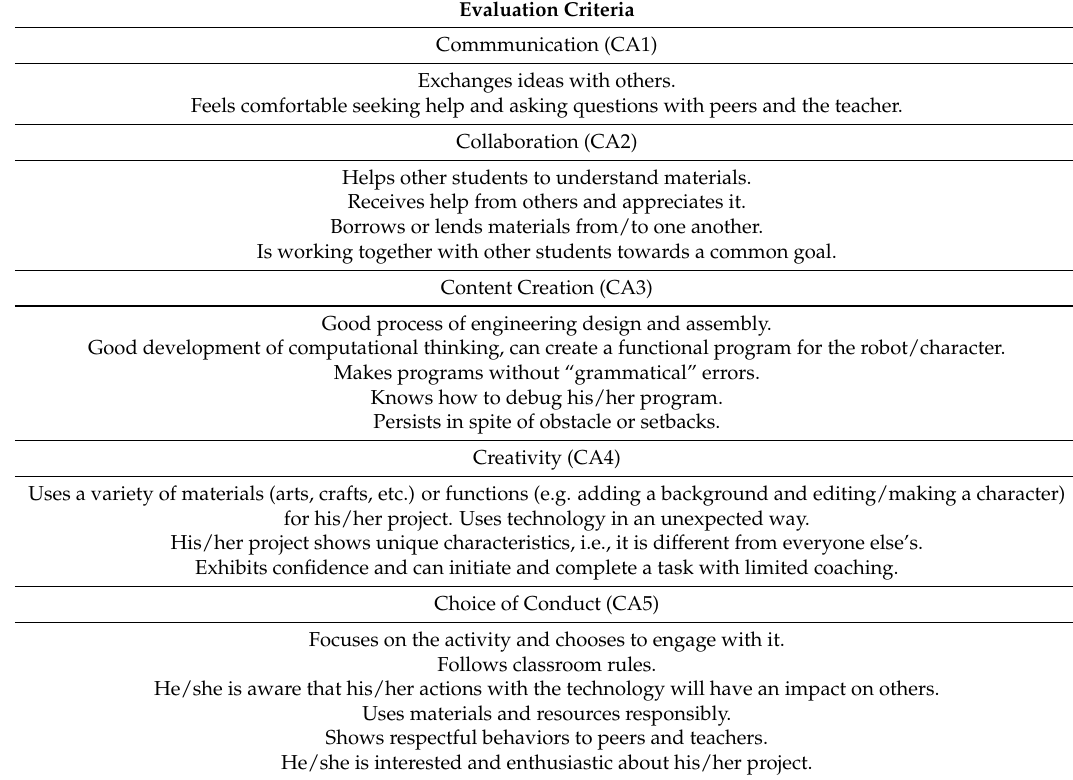
Table A1. List of evaluation criteria used to evaluate the students’